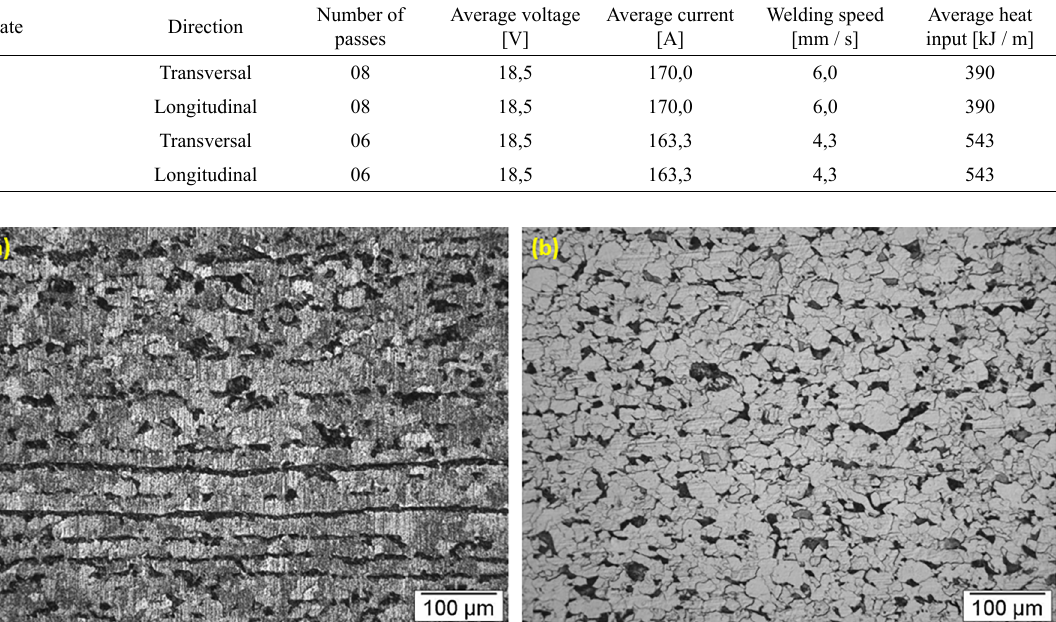
Figure 3 . Microstructures of the longitudinal section (a) and transversal